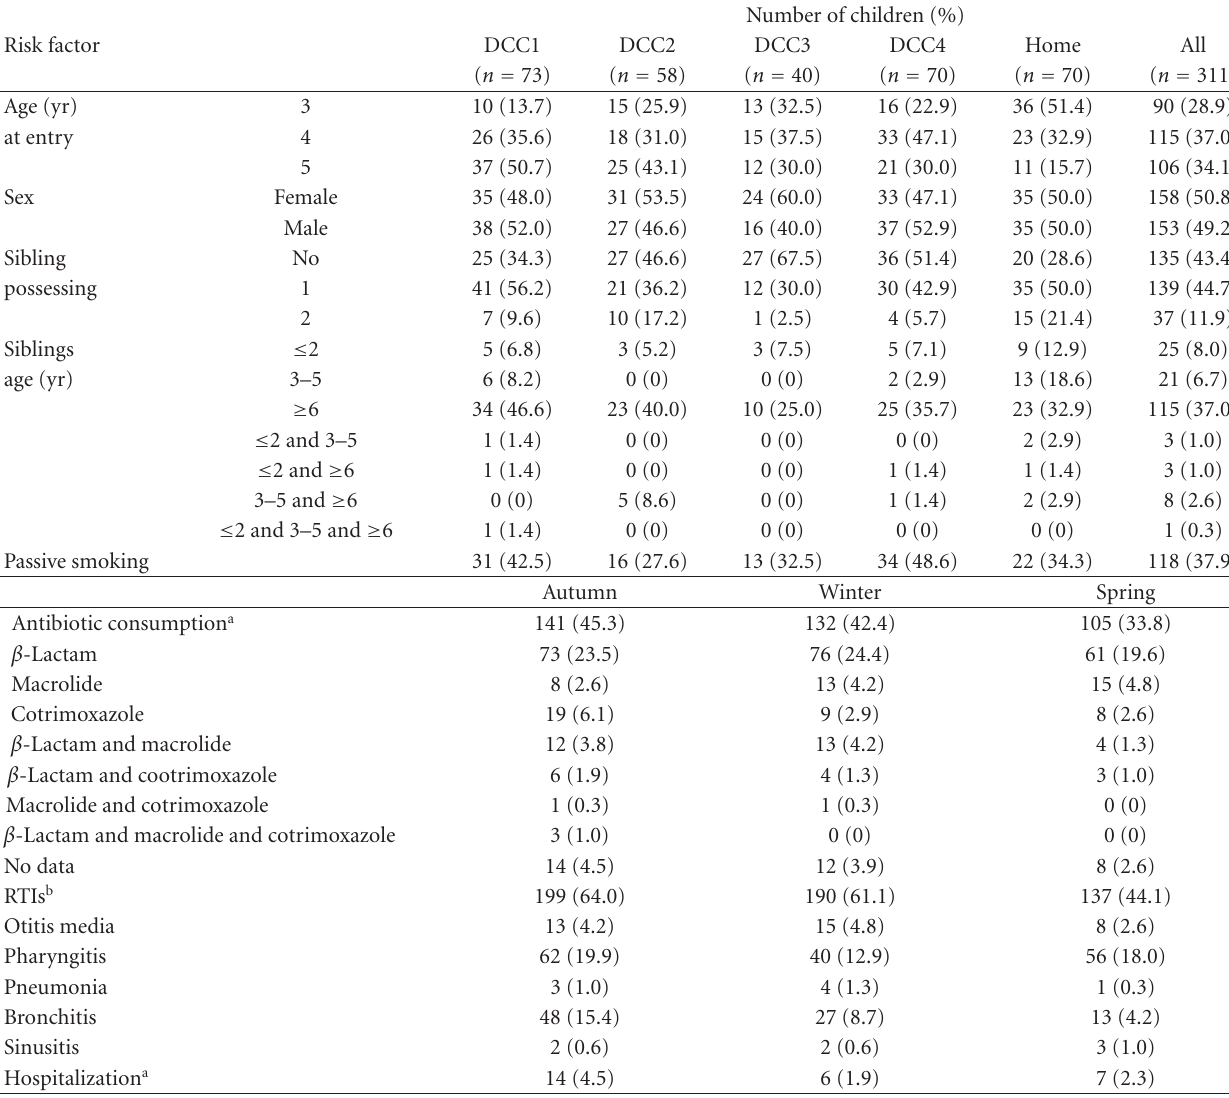
Table 1: Demographic data of studied